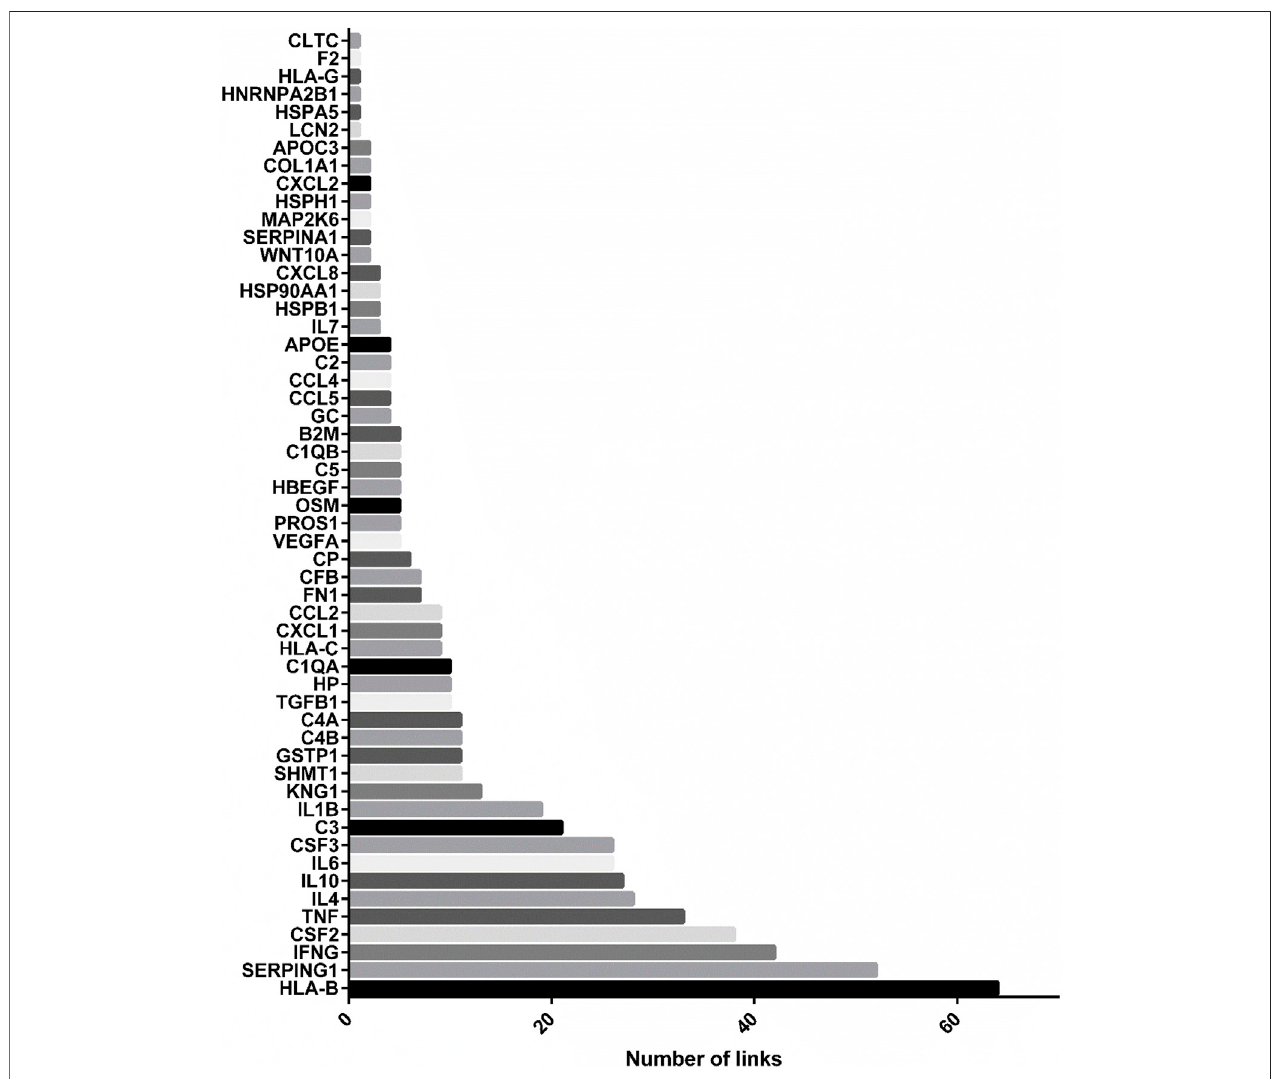
FIGURE 4 | Most linked genes in CURDi network. The histograms show the most linked genes to immune system diseases in CURDi: HLA-B, SERPING1 and IFNG.